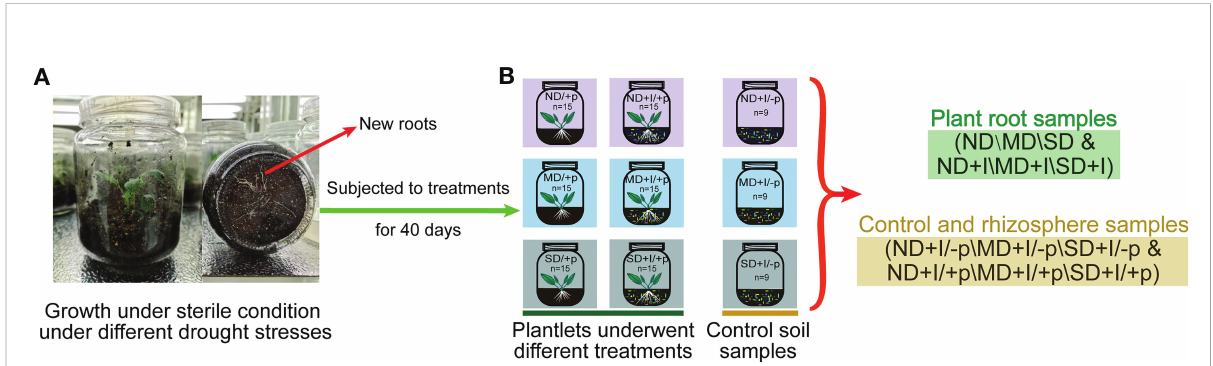
FIGURE 1 Schematic diagrams of the work fl ow of this study. (A) The drought stress and microbial inoculation treatments. (B) Samples subjected to microbial diversity analyses. ND, no drought stress (0% PEG6000); MD, mild drought stress (10% PEG6000); SD, severe drought stress (25% PEG6000); +I, with Geo-authentic soil microbe inoculation; +p, with A lancea plantlet; -p, without A ancea